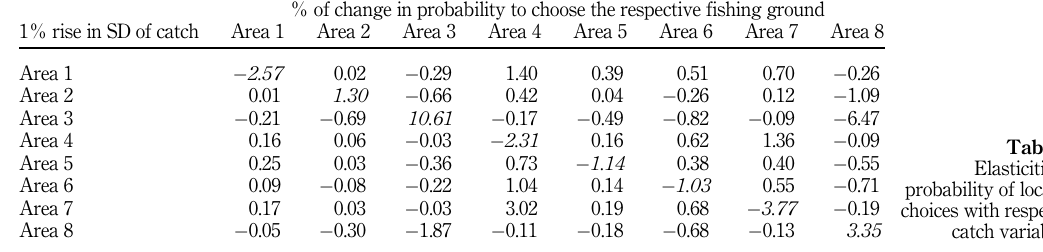
Table 8. Elasticities of